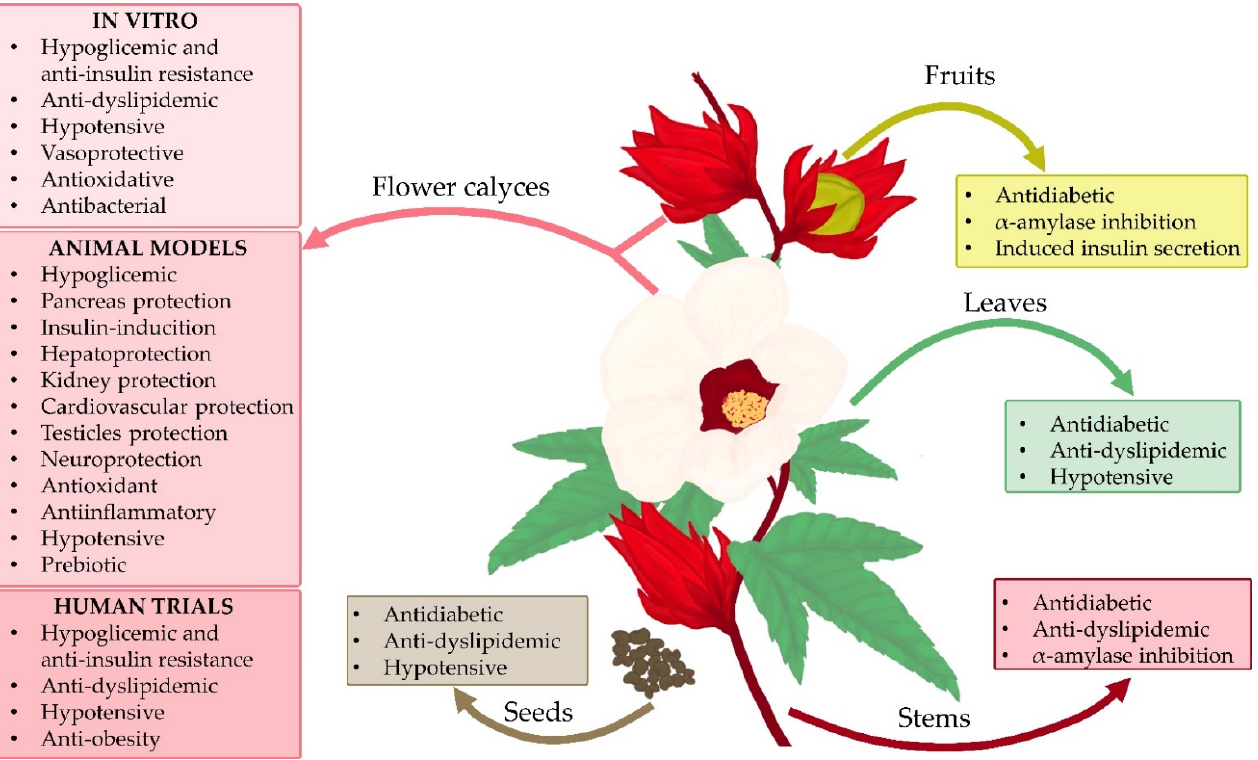
Figure 2. Beneficial effects of different parts of roselle in diabetes and its complications.